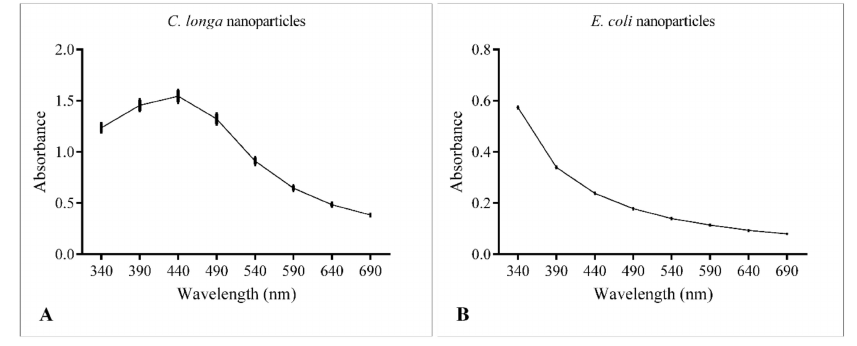
Figure 2. UV-Vis spectroscopy of ClAgNPs ( A ) and EcAgNPs ( B ).